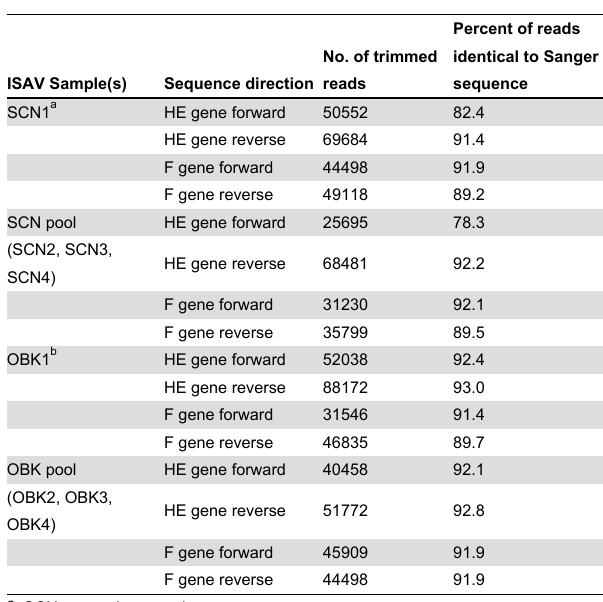
Table 1. Raw data from UDPS of partial ISAV HE- and F gene